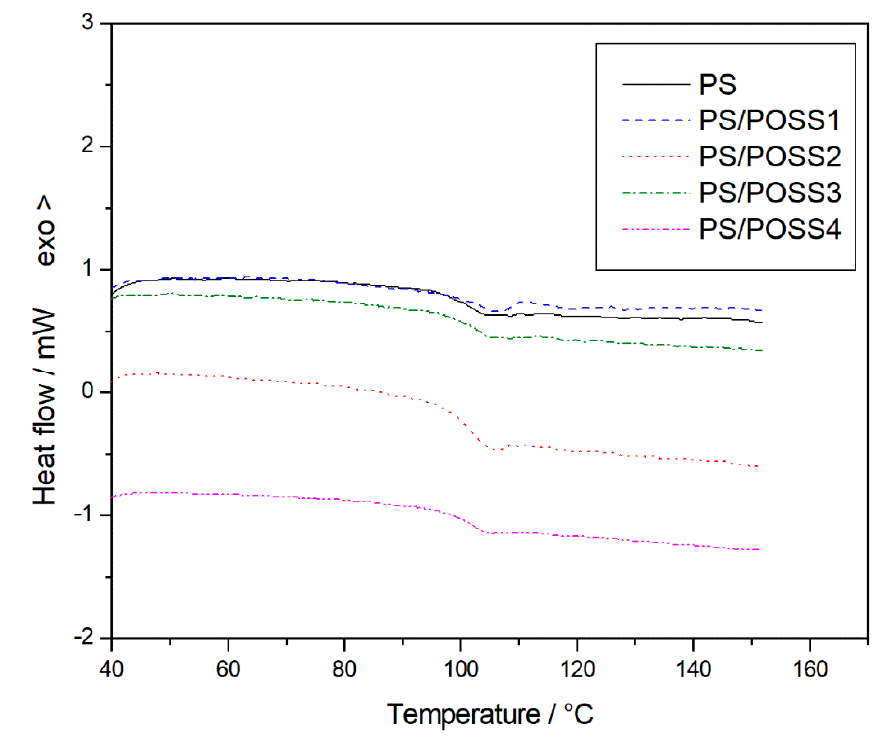
Figure 6. Differential Scanning Calorimetry curves for PS and prepared nanocomposites. Table 2. Glass Transition Temperatures ( T g ), Temperatures at 5% mass loss ( T 5% ) and residue % at 700 ◦ C or PS and synthesized POSS / PS nanocomposites in flowing nitrogen and in static air